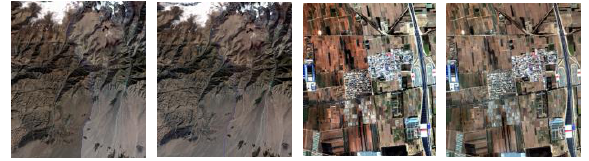
Figure 3 comparison of the dodge point edition Figure 3 respectively reflect the mountain area and urban area and original color difference between image and evasion point after the adjustment effect, mountainous image acquisition time respectively on October 1, 2016 and 2016 on August 5, left and